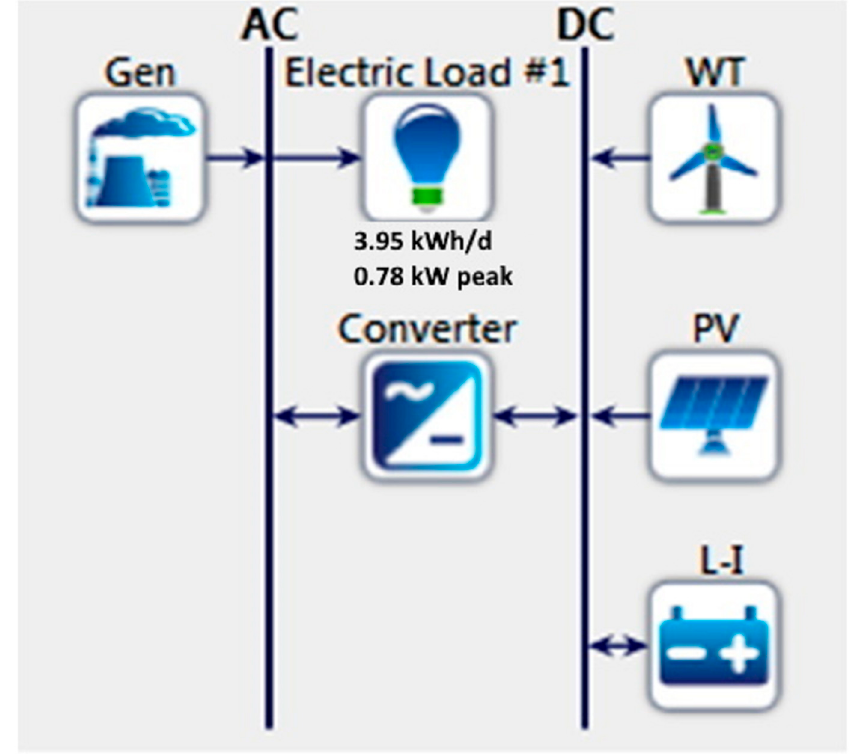
Figure 5. Energy sources used in the HOMER program.